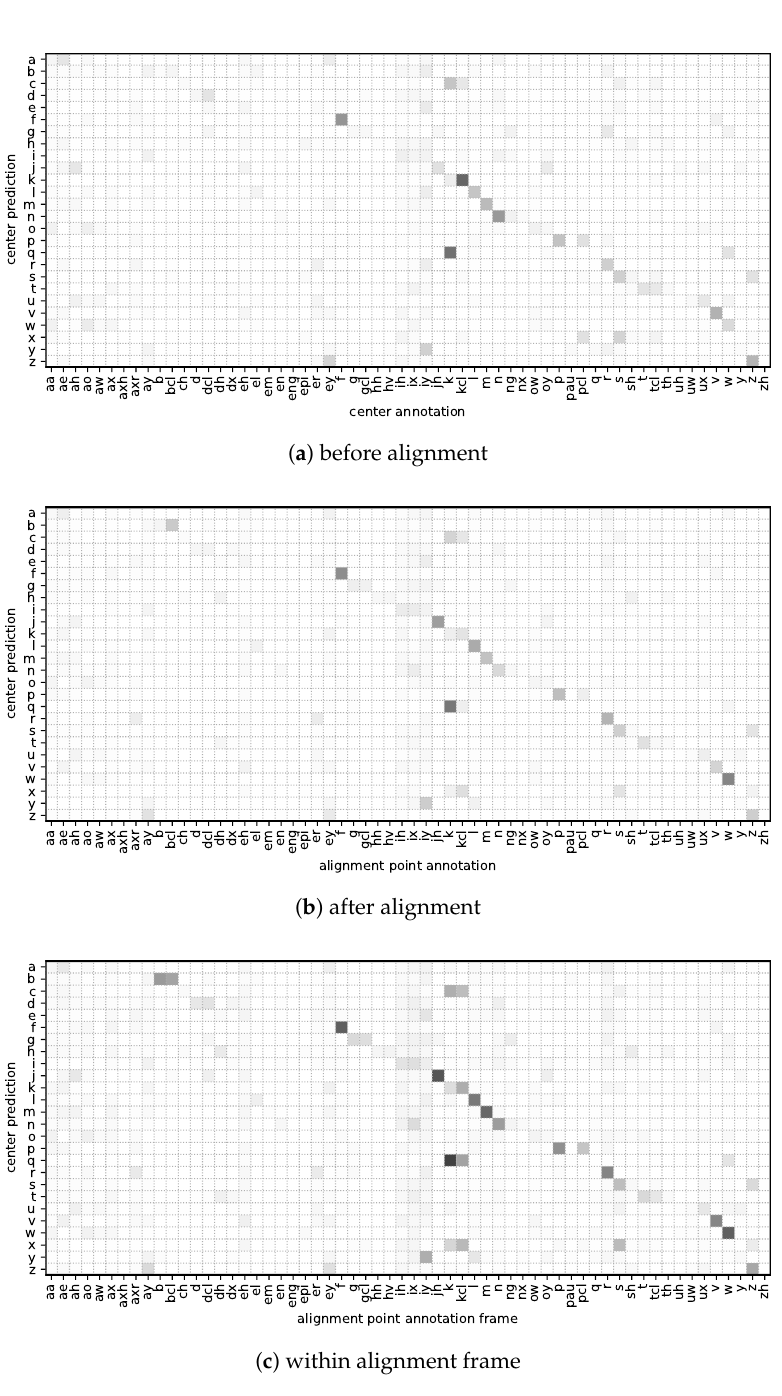
Figure A3. Alignment evaluation overview for model W2L. For each predicted letter on the y -axis the relative frequency of the corresponding phoneme annotation on the x -axis. Color scale [0, 1] from white to